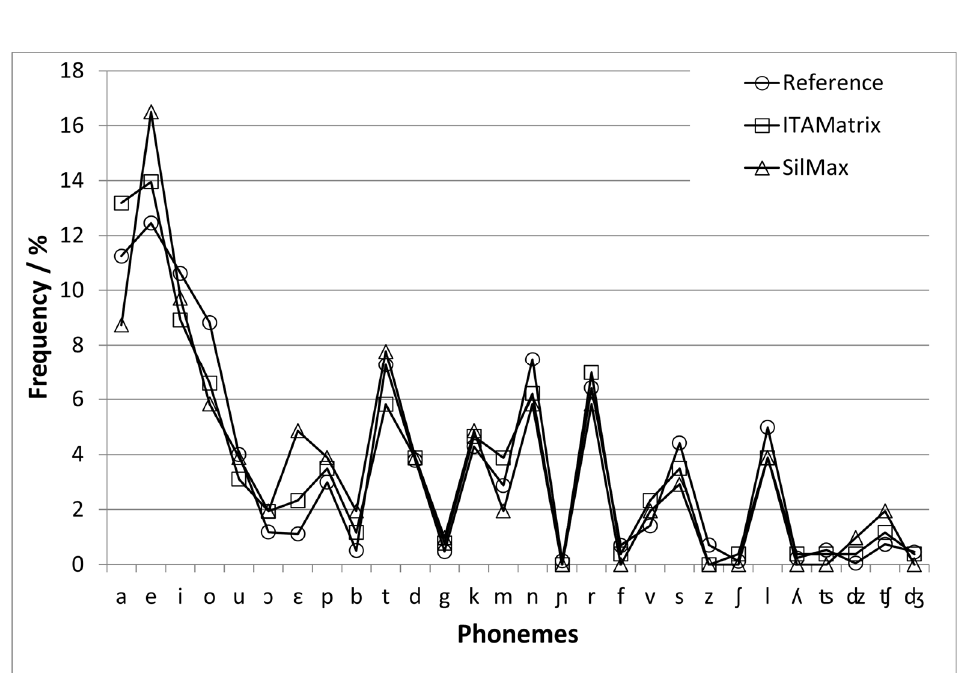
Figure 1. Phoneme distribution of the ITAMatrix (squares), SiIMax (triangles) and reference distri- bution for the Italian language (circles). The phonemes were transcribed using the symbols of the International Phonetic Alphabet.